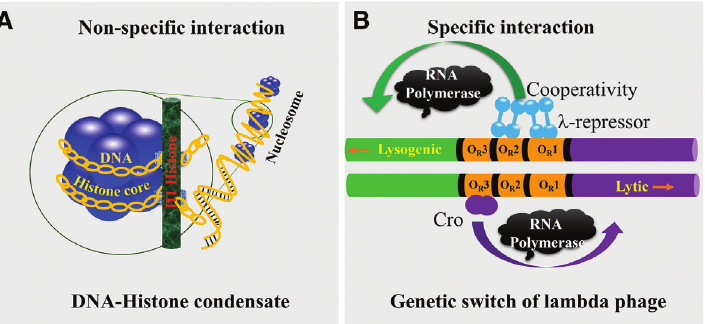
Figure 1 Schematic representation of non-specific (DNA-histone I) and specific protein-DNA (operator DNA with lambda/crorepressor) interaction and their